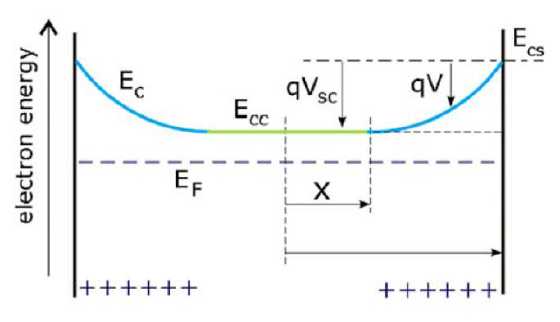
Figure 9. Schematic energy diagram in the radial direction of a nanowire indicating the depletion layer at the surface and the quasineutral region of radius x in the center where V is the potential, V is the potential drop across the depletion layer, E sc is the Fermi level (adopted from Ref. the conduction band, E F